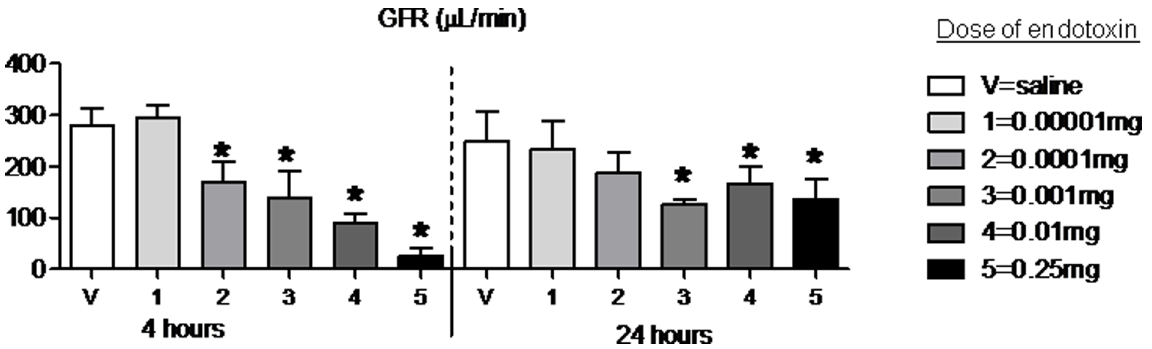
Figure 3. Glomerular filtration rate (GFR) 4 and 24 hours after 5 different doses of intraperitoneal endotoxin. GFR, by FITC-labeled inulin clearance, was determined 4 and 24 hours (hr) after intraperitoneal saline injection (V, vehicle] or intraperitoneal injection of 5 different doses of